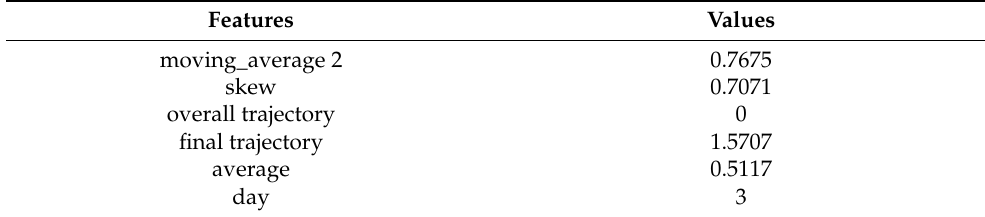
Figure 10. The SHAP Summary Plot for this Prediction Model . Table 10. Input Values for SHAP Force Plot 1. Table 10. Input Values for SHAP Force Plot 1.